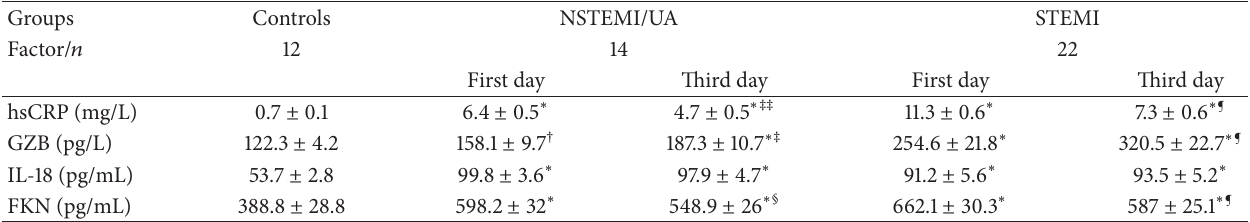
Table 3: Changes in blood levels of measured markers in STEMI and NSTEMI/UA groups.